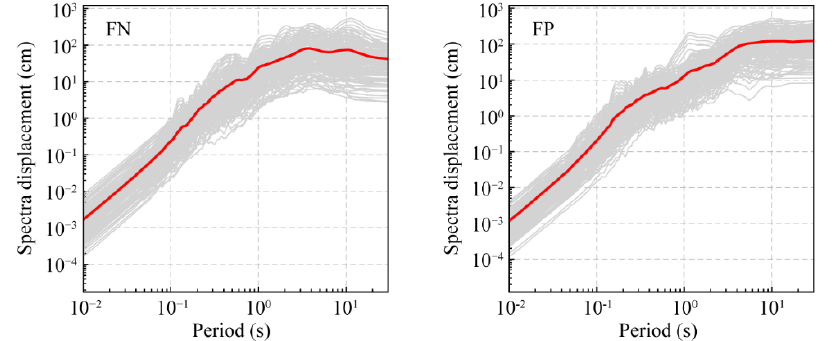
Figure 6. Response spectra of the 150 ground motions.